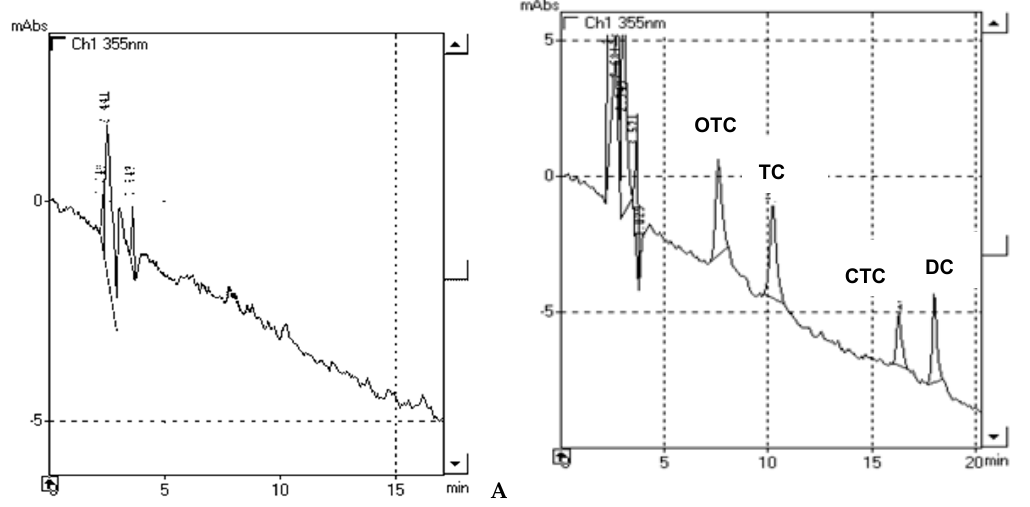
A B Figure 2. Typical HPLC chromatogram of OTC, TC, CTC and DC in milk, monitored at 355 nm, using the chromatographic conditions described in text. A : Blank milk sample. B : Spiked milk sample at 200 μ g/kg.